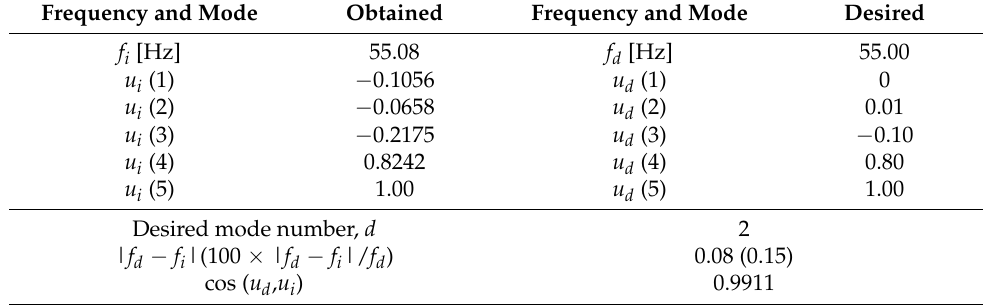
Figure 16. Original FRFs and FRFs after the addition of connection stiffness. Table 10. Comparison of natural frequencies and mode shapes. Frequency and Mode